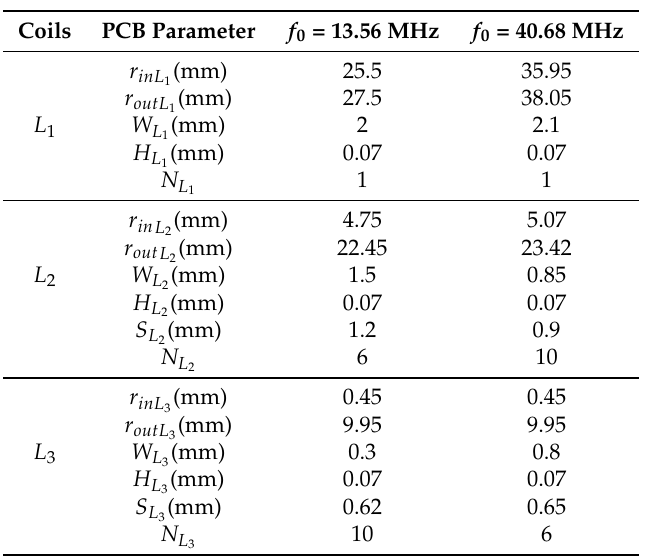
Table 2. Optimized geometries for proposed coil